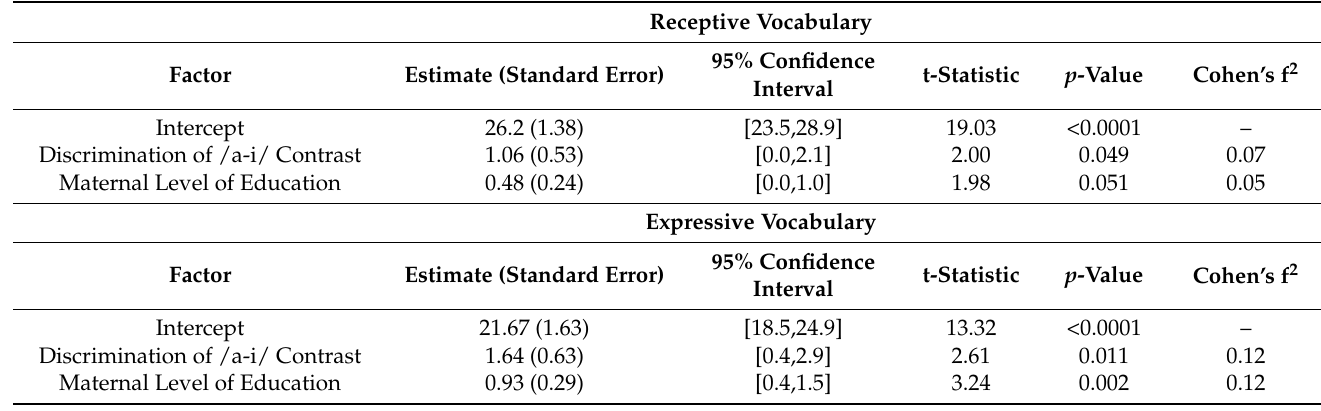
Table 6. Results of multivariate regression predictive Mullen Scales of Early Learning (MSEL) receptive and expressive spoken vocabulary.